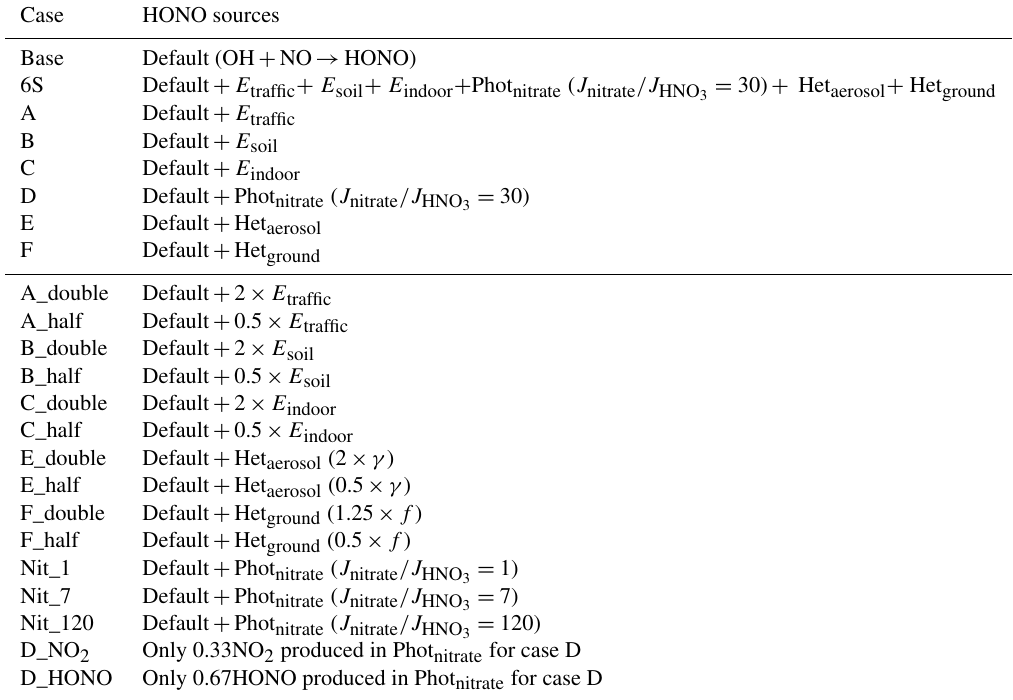
Table 2. Simulation scenarios designed in this study.